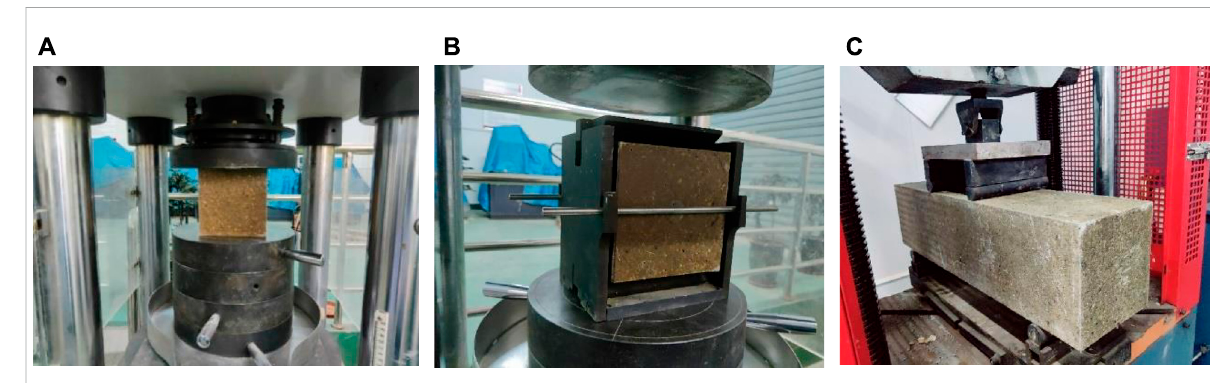
FIGURE 2 Mechanical properties test procedure. (A) Compressive test, (B) Splitting tensile test, (C) Flexural tensile